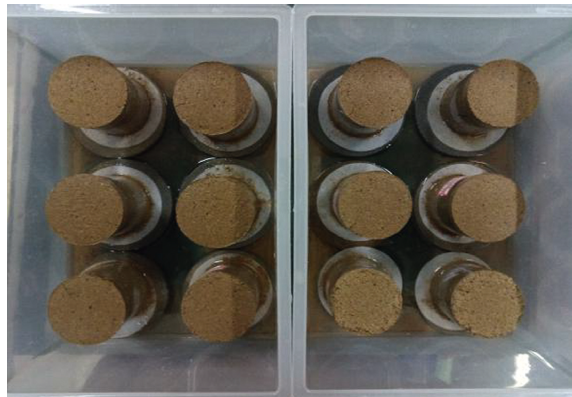
Figure 5: Drying-wetting cycling test in the present